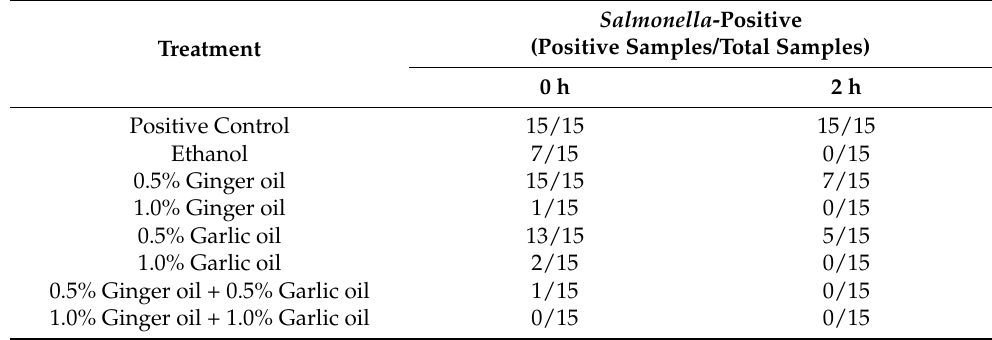
Table 2. Antimicrobial efficacy of phytochemicals as scalding tank treatment to reduce S. infantis in the treatment solutions after treatment and 2 h after